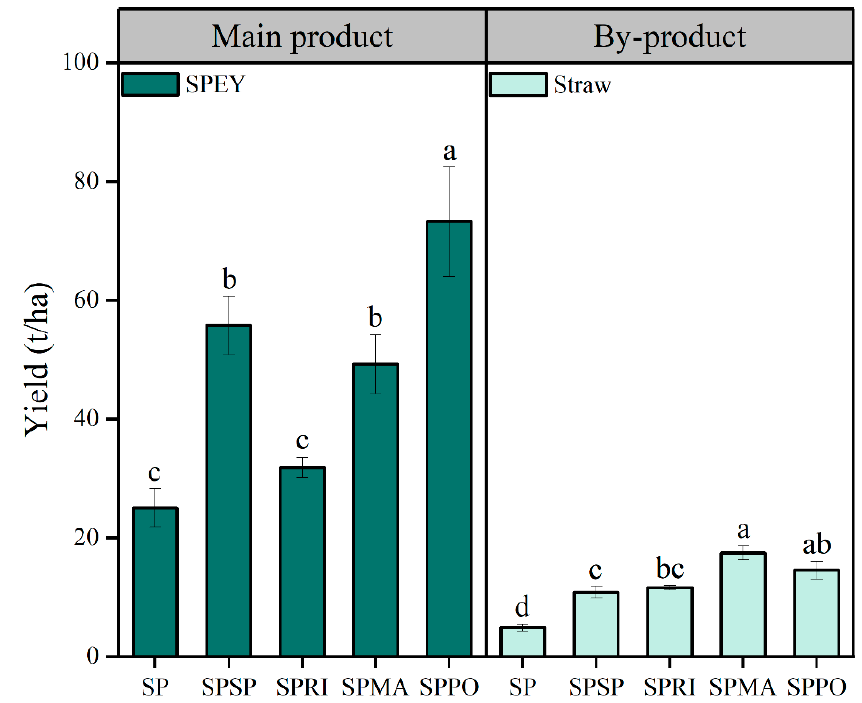
Figure 3. The main product yield (sweet potato equivalent yield, SPEY) and by-product (straw) yield of mono cropping of sweet potato (SP); continuous cropping of sweet potato (SPSP); and rotation cropping system of sweet potato–rice (SPRI), sweet potato–maize (SPMA), and sweet potato– potato (SPPO). The different lowercase letters indicate significant differences within cropping system treatments at p < 0.05. Bars represent standard errors.